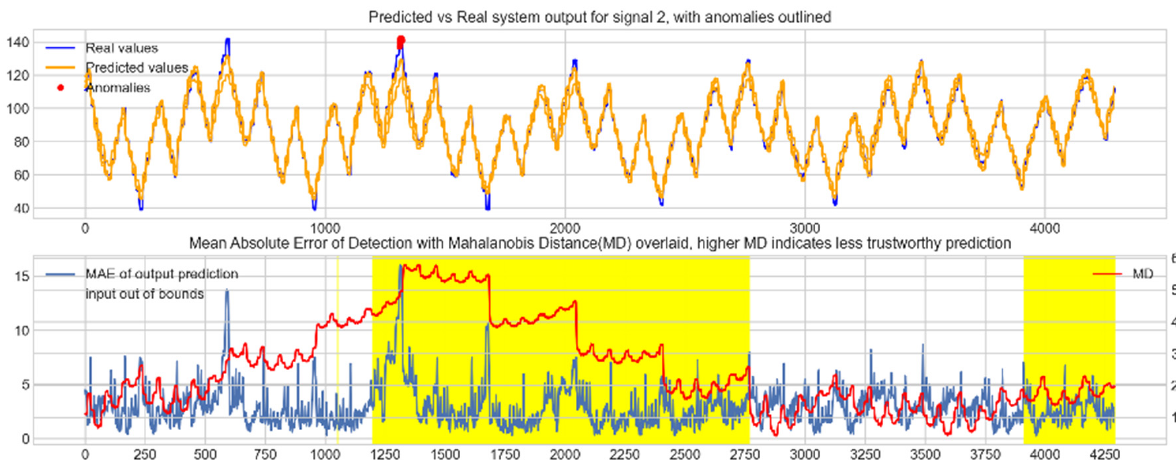
Figure 11. Predicted vs. real device output for signal 2, the left elevon, with anomalies labelled ( top ); MAE, MD and boundary check corresponding with the prediction ( bottom ). The yellow shaded areas represent new inputs outside expected input space.